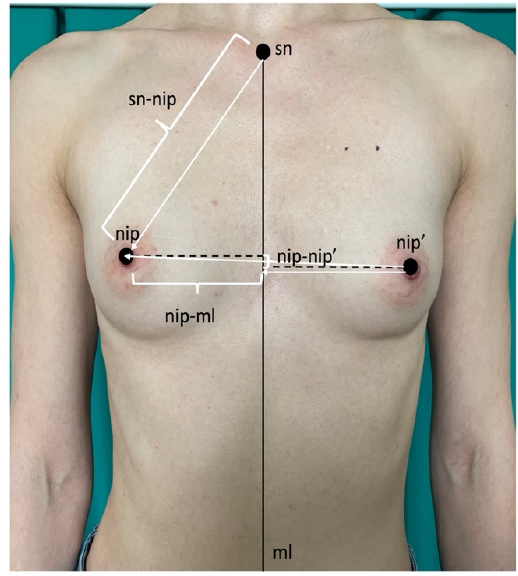
Figure 1. Anthropometric points and measurements analysed in the